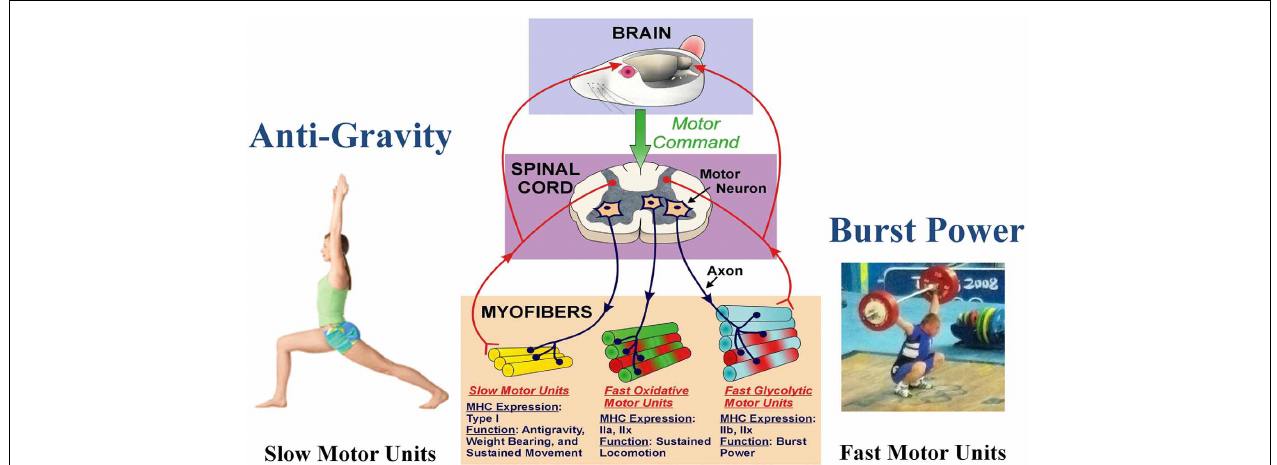
FIGURE 1 | Functional specialization of skeletal muscle. The brain initiates the motor command for a motor neuron to fire and stimulate a group of muscle fibers to contract. A motor unit consists of a single motor neuron together with all the muscle fibers it innervates. Different types of motor units express different MHC phenotypes, having a specialized function. Note that each myofiber can express either a single MHC isoform, or a hybrid mix